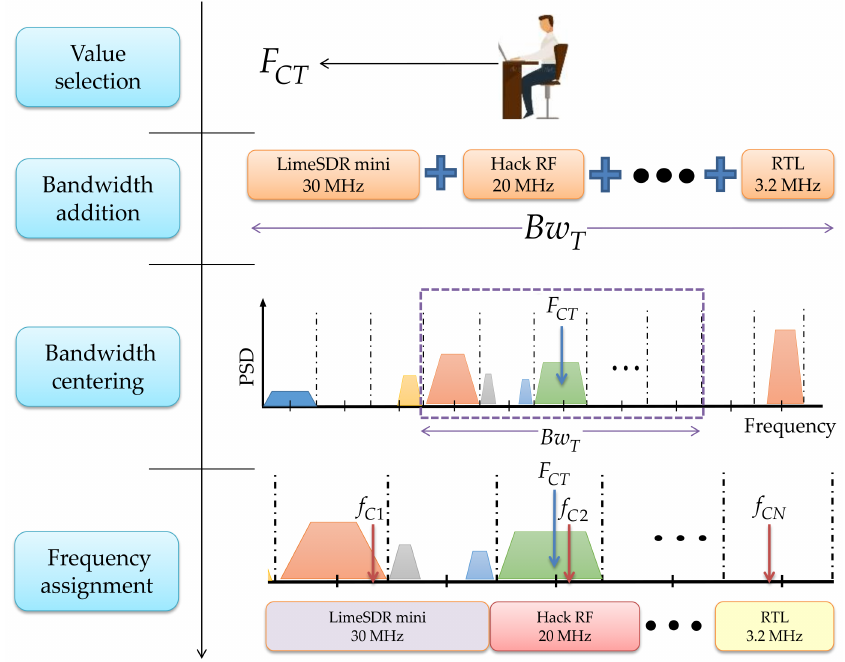
Figure 3. Carrier frequency assignment of each connected device to conform the observed multi- band